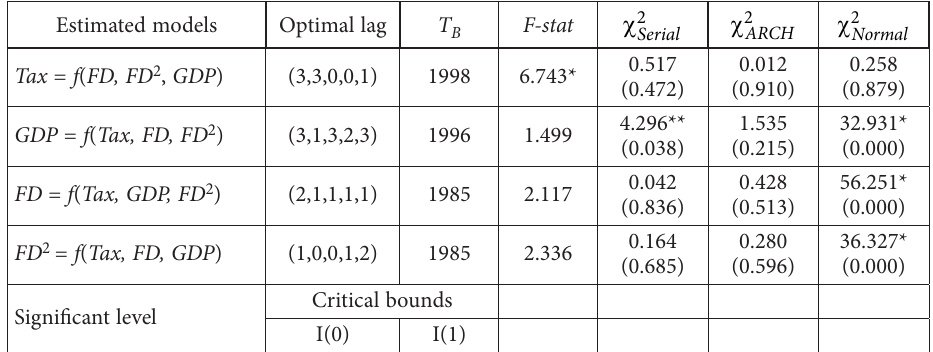
Table 6. The results for ARDL cointegration test Estimated